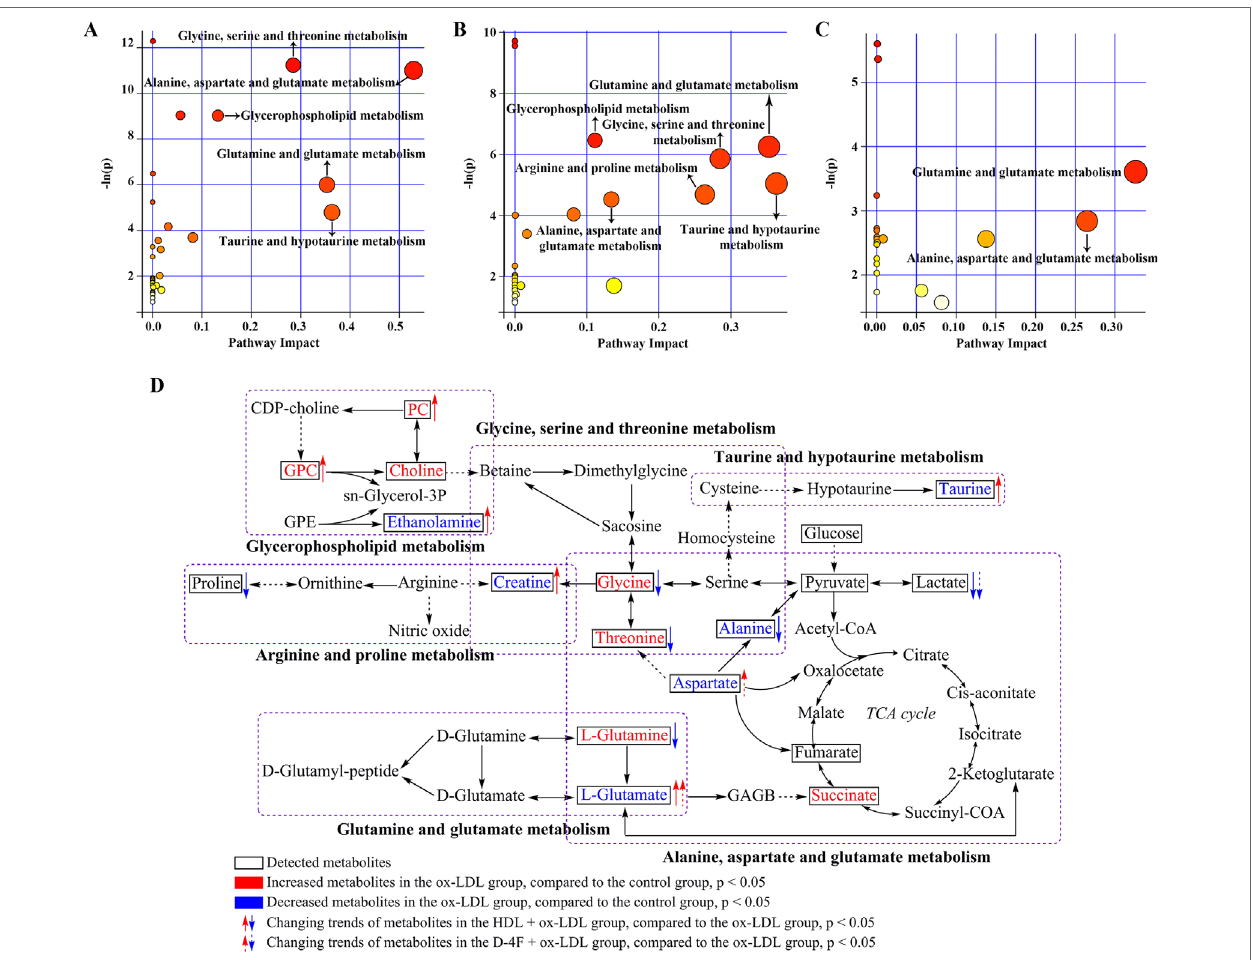
FIGURE 7 | Metabolic pathway analysis based on the characteristic metabolites screened from pair-wise comparisons. Based on both pathway impact values (PIVs) and p values, significantly altered metabolic pathways were identified from the pair-wise comparison of (A) ox-LDL vs. control; (B) HDL + ox-LDL vs. ox-LDL; (C) D-4F + ox-LDL vs. ox-LDL. (D) Illustration of significantly altered characteristic metabolites induced by either HDL or D-4F against ox-LDL based on the KEG database. The MetaboAnalyst 3.0 web server was used to perform the metabolic pathway analysis. Significantly altered metabolic pathways were identified on the base of the p values calculated from the metabolite set enrichment analysis ( p < 0.001) and the PIVs computed from the topology analysis (PIV >